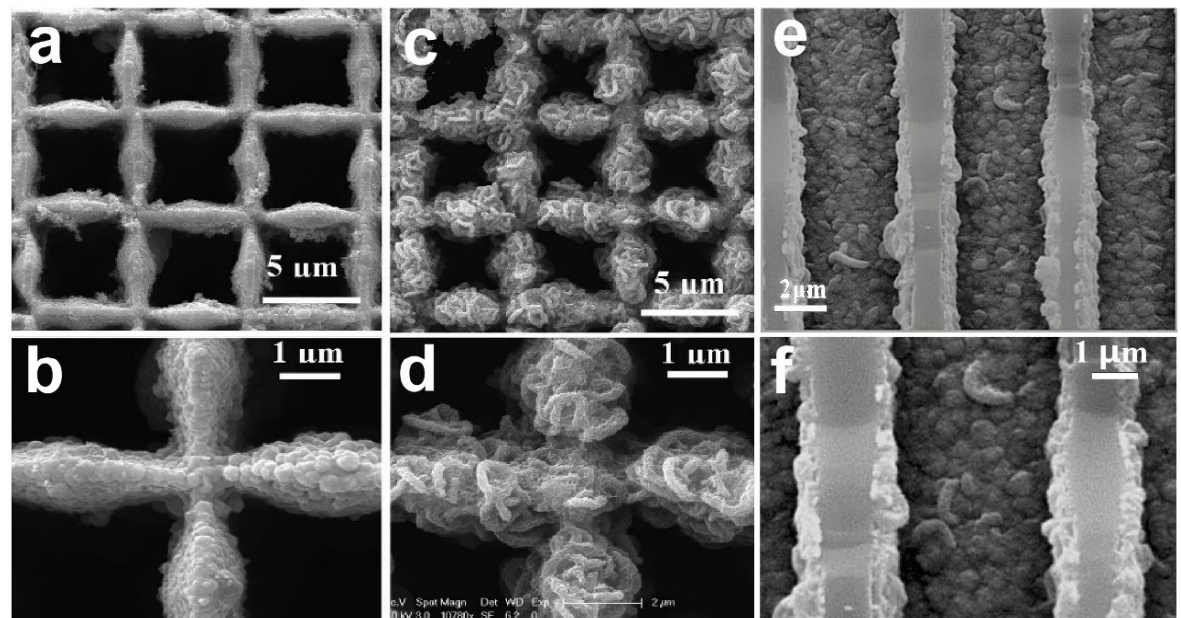
Figure 11. ( a , b ) Top view of n-MECN with different magnification; the SEM images of ( c , d ) Surface of MnCo 2 O 4 @n-MECN electrode with different magnification; ( e , f ) Cross-sectional images of MnCo 2 O 4 @n-MECN with different magnification. Reproduced with permission [79]. Copyright 2020, Elsevier.